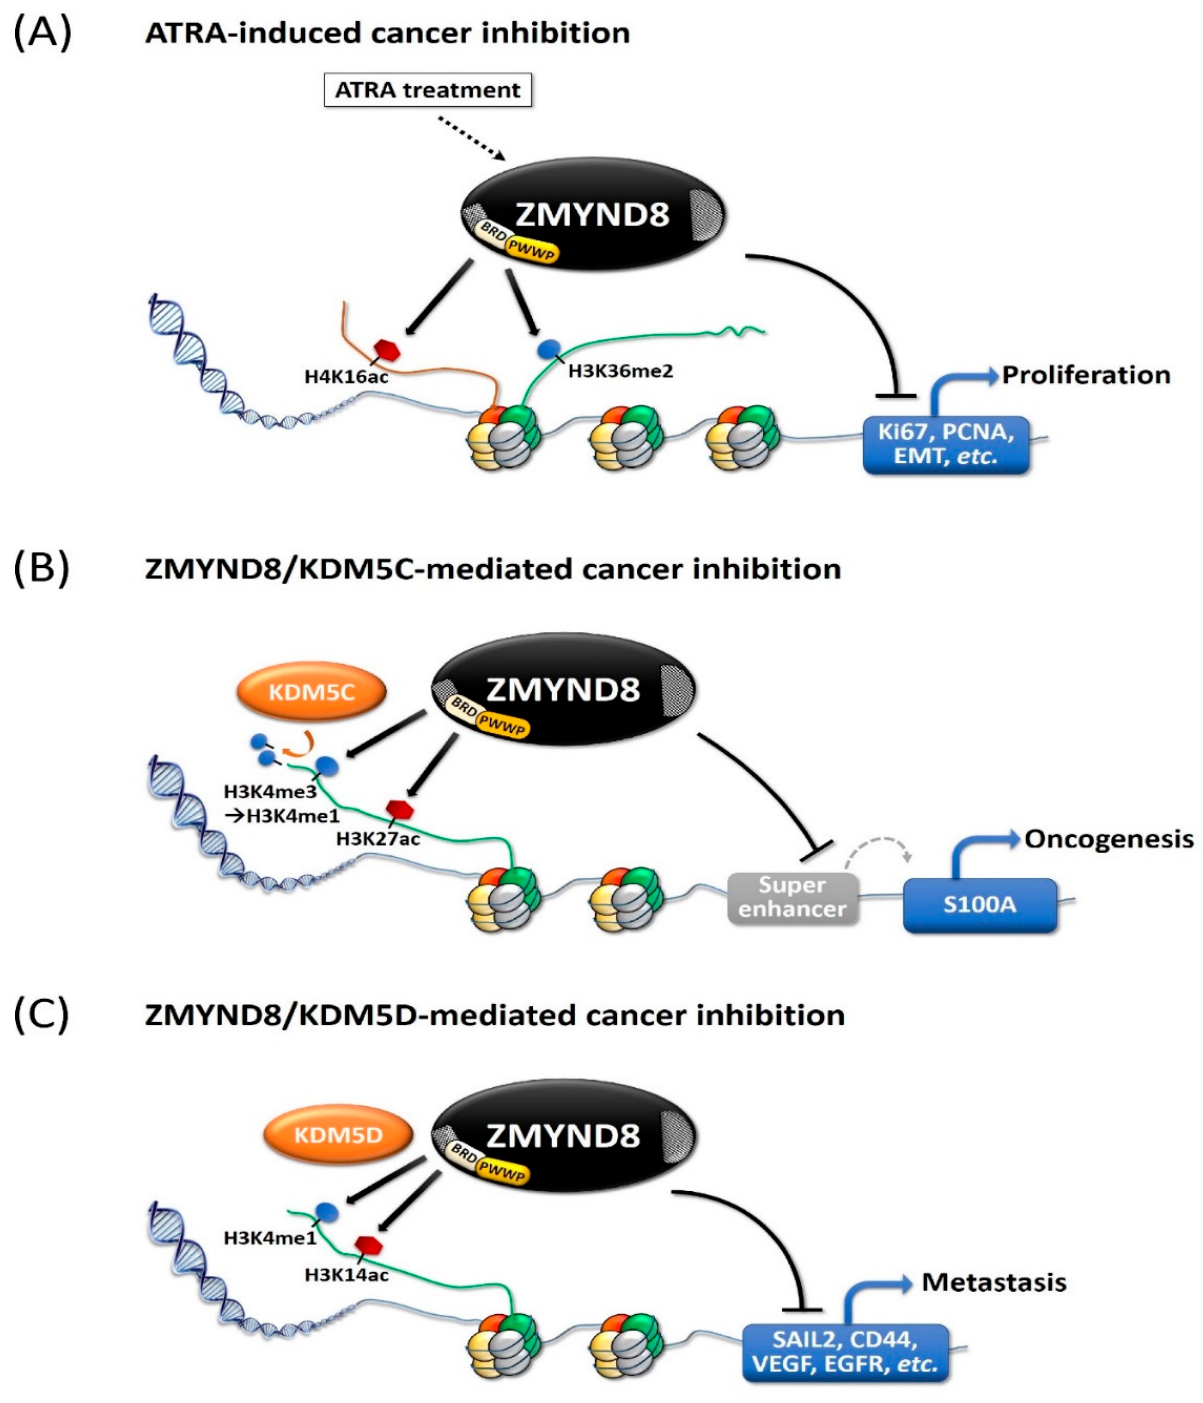
Figure 3. Diagrams showing the mechanisms of the tumor-suppression effects of ZMYND8 and demethylases. The tumor-suppression effects may involve recognition of dual histone marks. ( A ) The all-trans retinoic acid (ATRA)-induced inhibition of transcription of proliferation genes and epithelial–mesenchymal transition (EMT). ( B ) ZMYND8 cooperates with KDM5C to suppress super-enhancer and transcription of oncogenes in breast cancer. ( C ) ZMYND8 cooperates with KDM5D to suppress transcription of metastasis genes in prostate cancer. PCNA: Proliferating cell nuclear antigen; VEGF: Vascular endothelial growth factor; EGFR: Epidermal growth factor recep- tor.